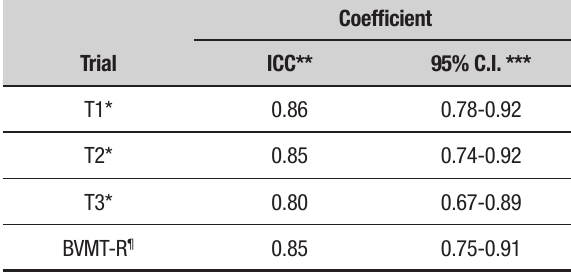
Table 3. Intraclass Correlation Coefficients of